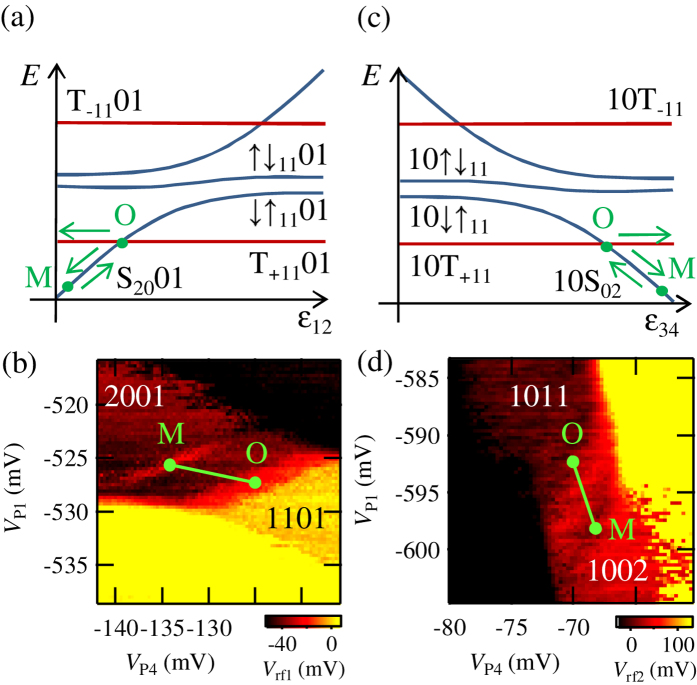
(a,c) Energy diagrams and schematics of the pulse operation to observe PSB in QD1 and QD2 (QD3 and QD4). The T+1101 (10T+11) component is populated at the operation point O by using the S1101 ⇔ T+1101 (10S11 ⇔ 10T+11) mixing. The triplet component is observed as the [1, 1, 0, 1] ([1, 0, 1, 1]) charge state at the measurement point M. (b,d) Observed Vrf1 (Vrf2) as a function of VP4 and VP1. The pulse sequences are indicated by lines in the figures. The change of Vrf1 (Vrf2) as the result of the spin blocked signals are observed around M.